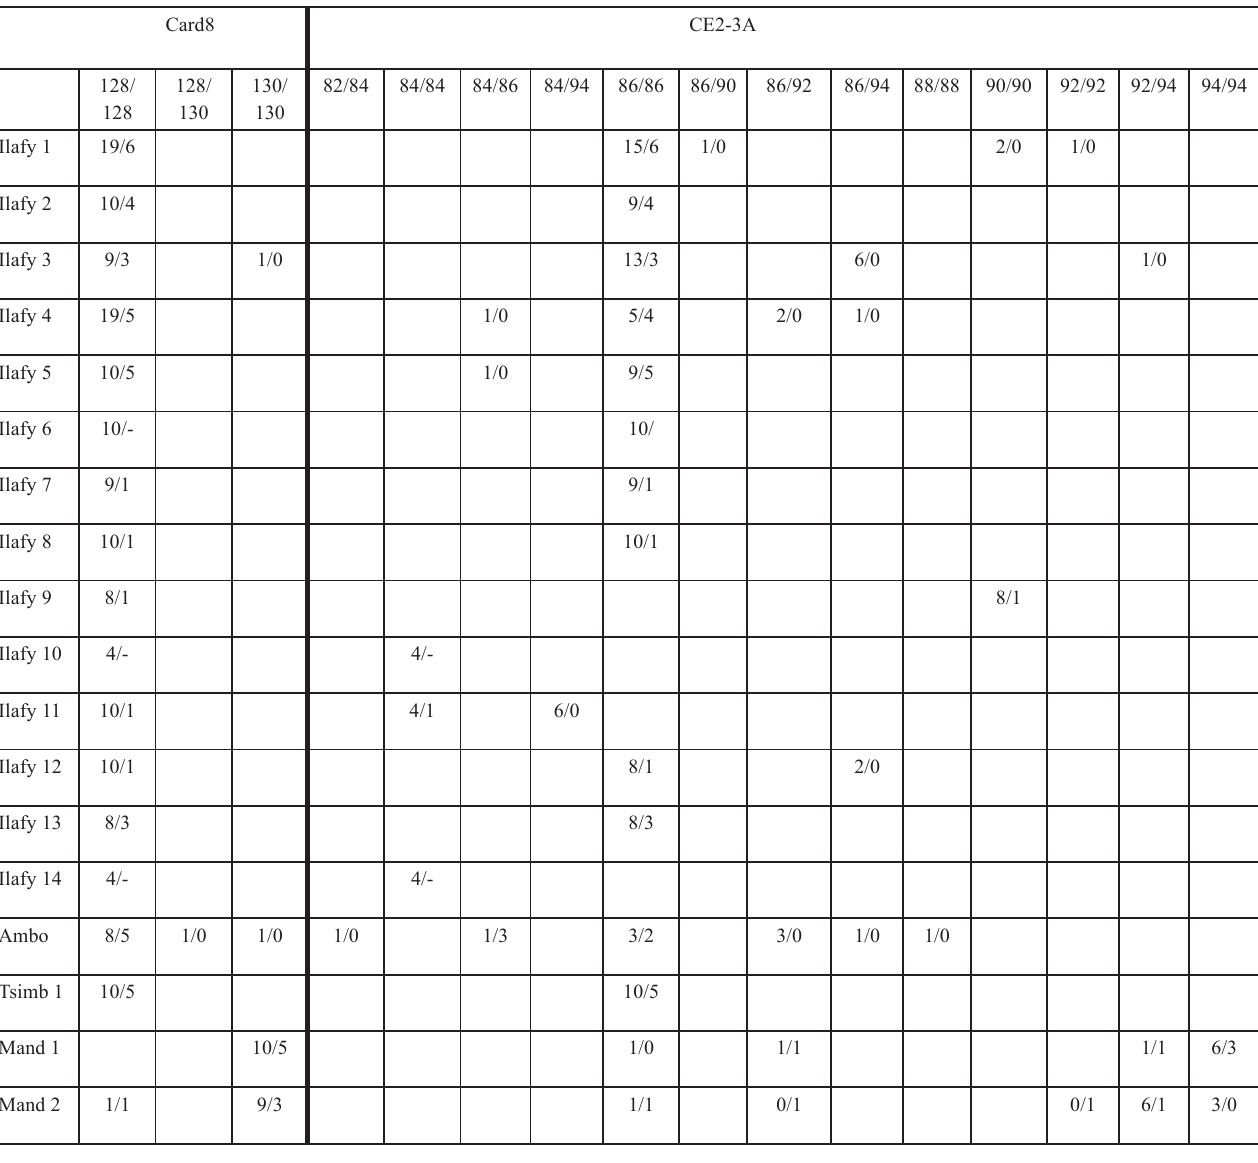
Table 1 - Genotypes of workers and queens of the ant Cardiocondyla shuckardi from 18 colonies from four populations on Madagascar (Ilafy, Ambohidrabiby, Tsimbazaza, Mandraka) at three microsatellite loci (1a:Card8, CE2-3A; 1b: CE2-12D). For each locus, the number of workers / queens with a certain genotype is